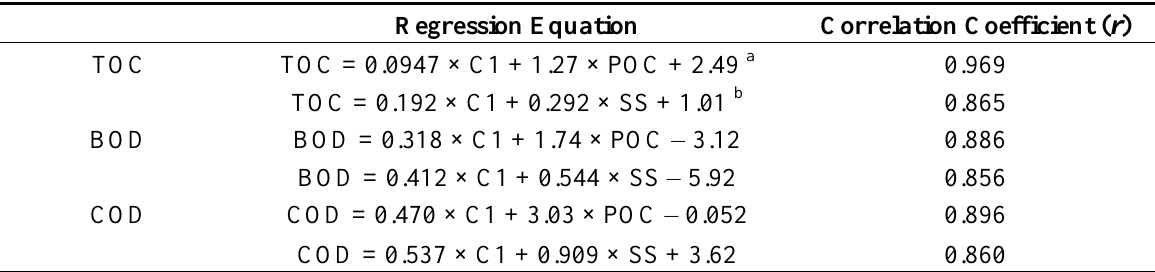
Table 3. Prediction of water quality parameters using multiple regressions based on F C1 and POC or F of C1 and SS. max